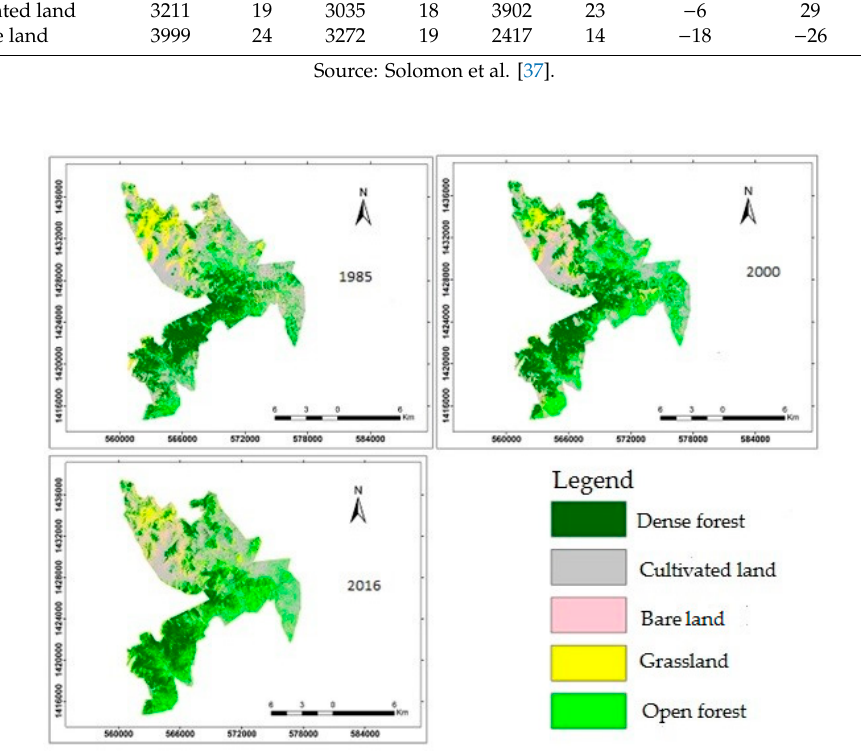
Figure 3. Land cover change in Wujig Mahgo Waren forest in 1985, 2000, and 2016. Table 2. Accuracy assessment of classified images.